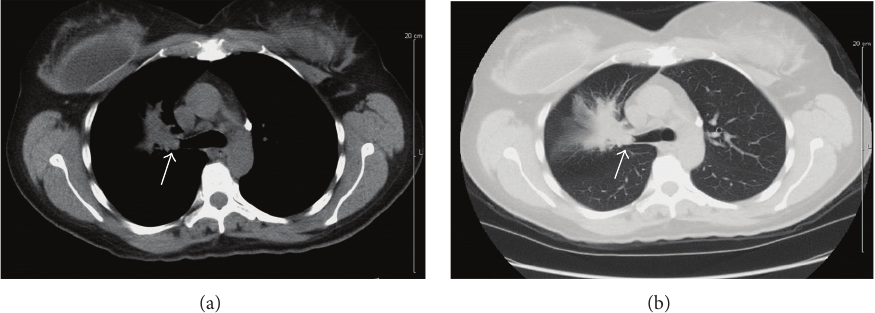
Figure 1: Computerized tomography (CT) of the chest showing a mass (arrow) measuring 1.5–2cm obstructing the right upper bronchus with associated atelectasis. No evidence of metastatic disease is seen. (a) Mediastinal window. (b) Lung